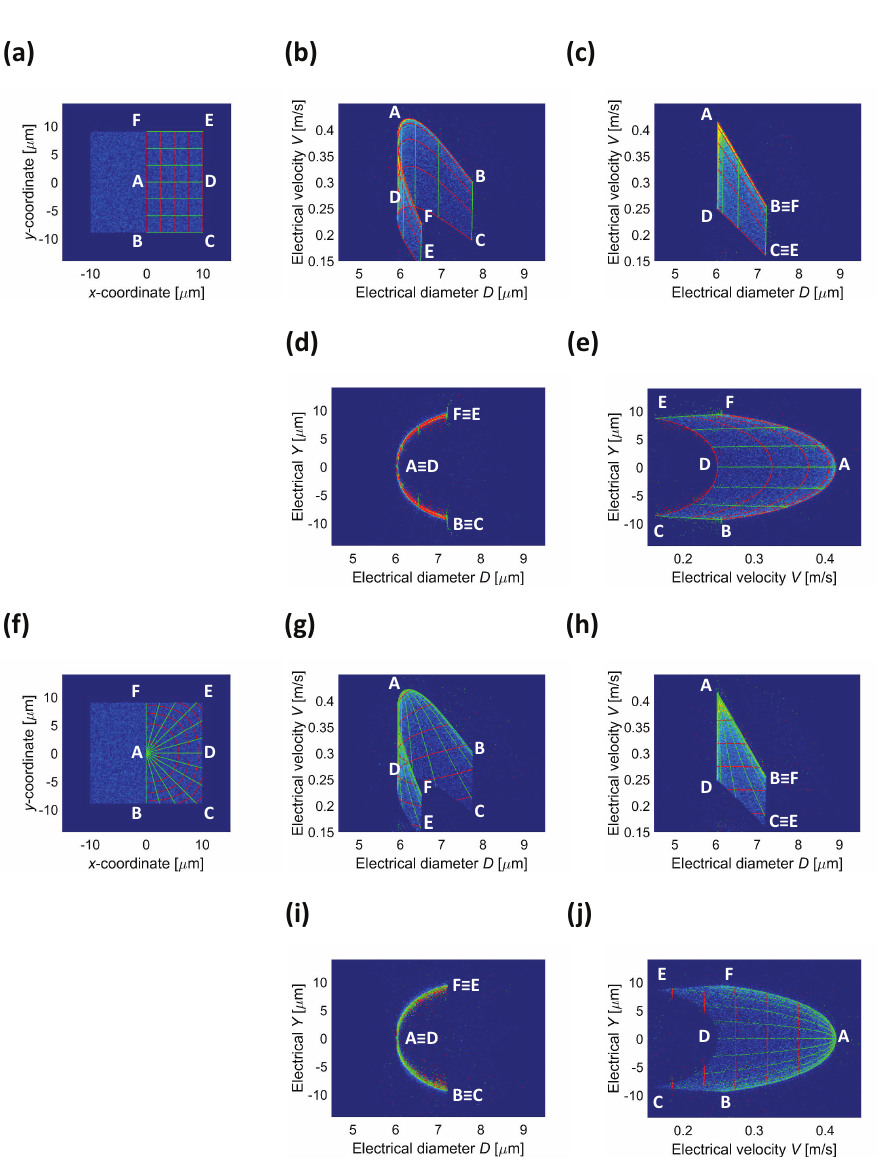
). ( c , h ) Density plots of 6 ). 6